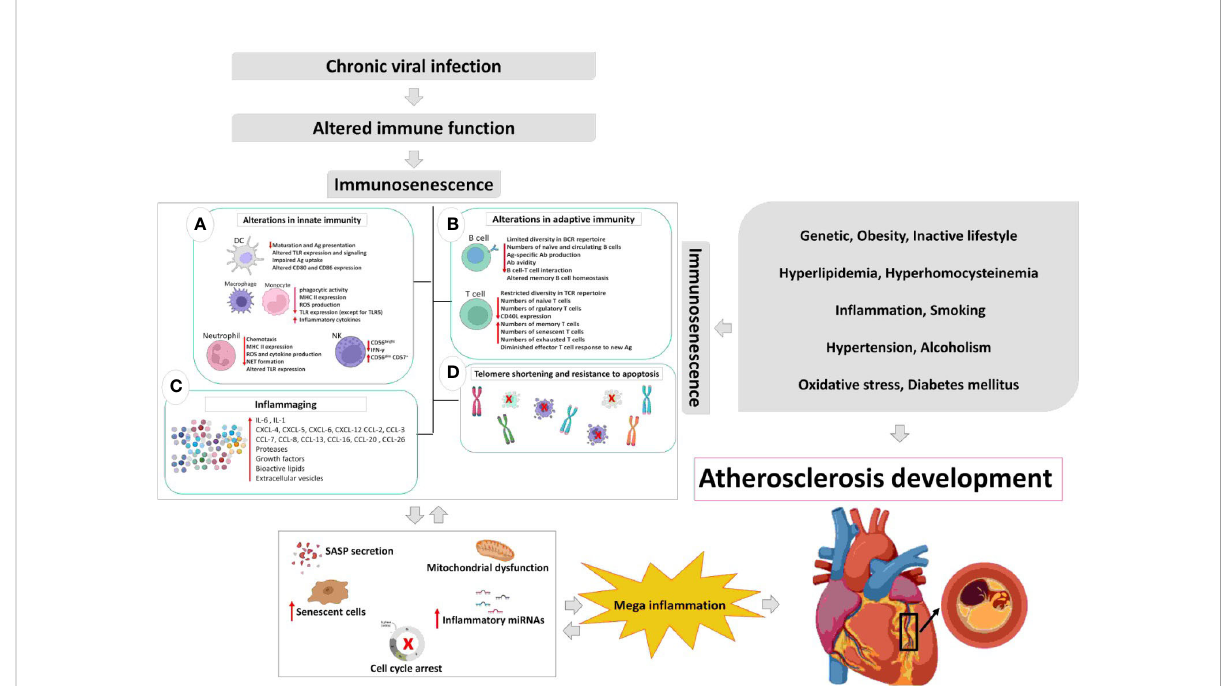
FIGURE 2 The relation between chronic viral infection-induced immunosenescence and atherosclerosis development. Chronic viral infections modify immune responses and immune functions over the time course of infection. The hallmark of most chronic viral infections is in fl ammaging, which triggers cell cycle arrest, SASP secretion, mitochondrial dysfunction, telomere shortening, and immunosenescence. Such alterations are accompanied by acceleration of atherosclerosis even in younger adults, thereby; in a positive feedback loop in fl ammaging accelerates atherosclerosis and ageing of the immune system. DC, dendritic cell; Ag, antigen; TLR, toll-like receptor; MHC, major histocompatibility complex; ROS, reactive oxygen species; NET, neutrophil extracellular traps; NK, natural killer; BCR, B cell receptor; Ab, antibody; TCR, T cell receptor; SASP, senescence-associated secretory